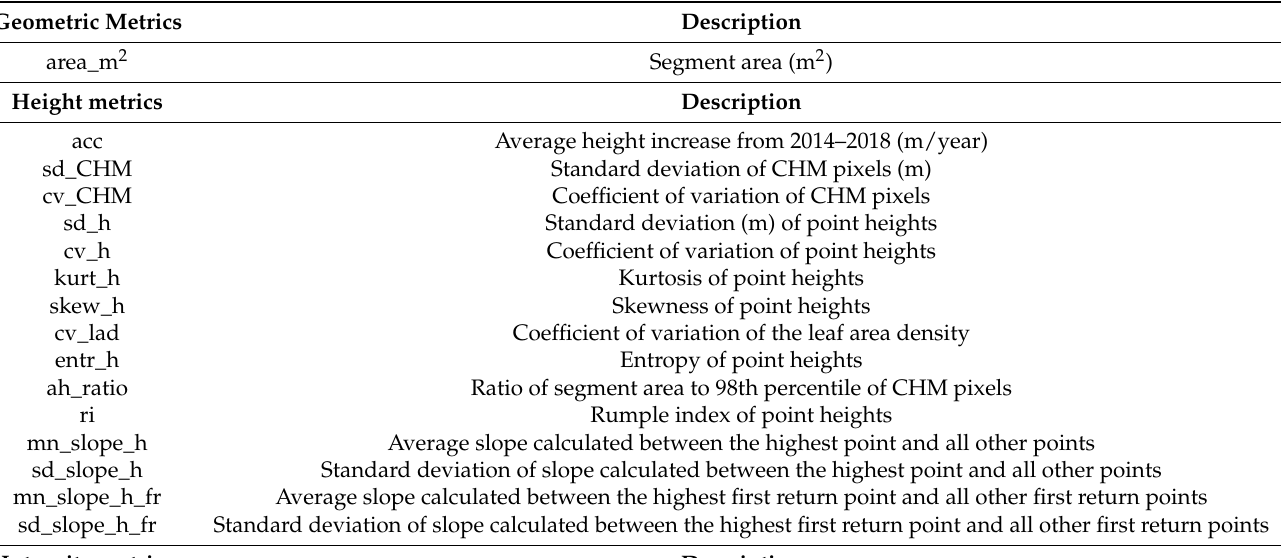
Table A1. ALS metrics calculated for each segment. The name of each metric is indicated and followed by a description. Intensity metrics were calculated for both channels (C1 and